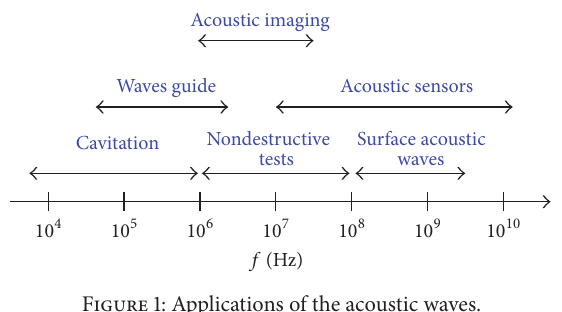
Figure 1: Applications of the acoustic waves. Table 1: Frequency scale of the acoustic